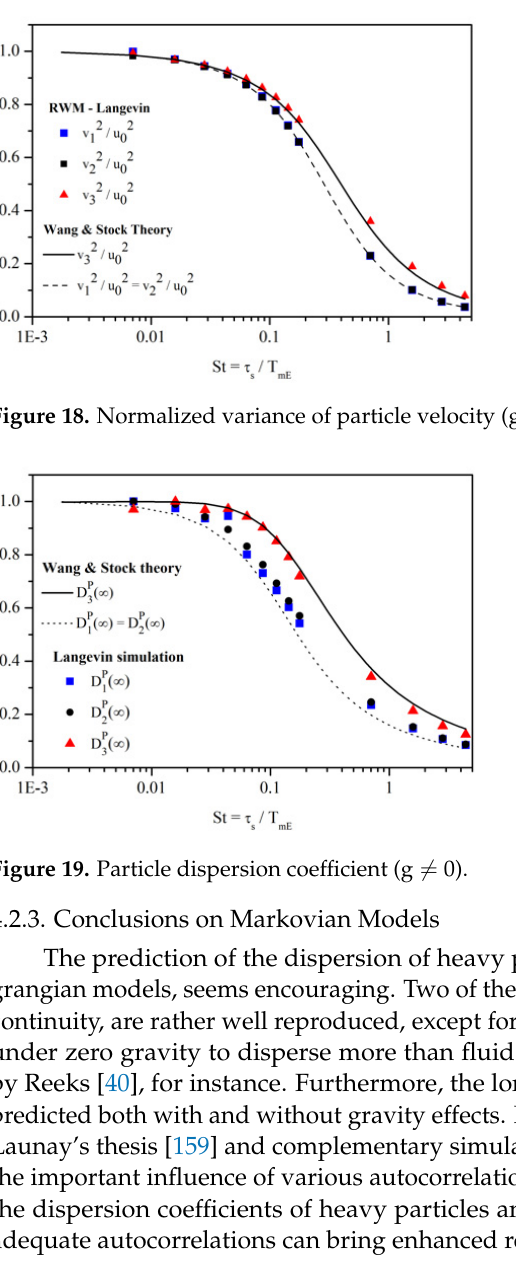
Figure 17. Particle Lagrangian time scale (g ≠ 0).